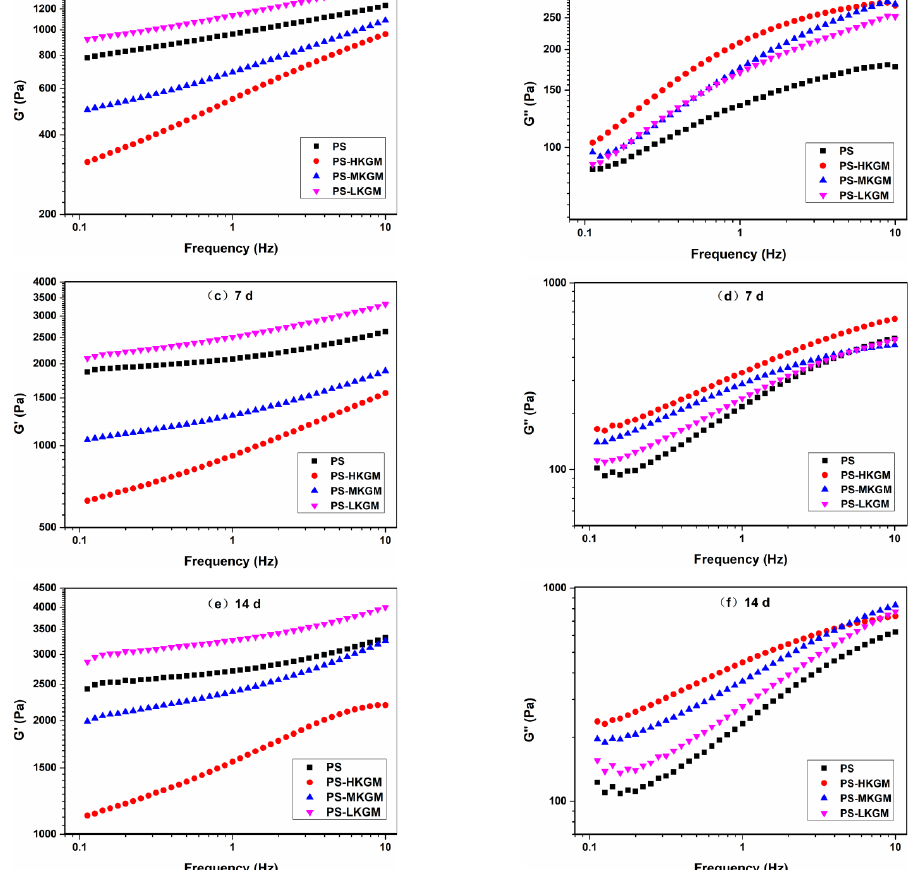
Figure 2. Frequency sweeping curves of PS - KGM mixtures at different storage times are as follows: ( a ) storage modulus at 1st day; ( b ) loss modulus at 1st day; ( c ) storage modulus at 7th day; ( d ) loss modulus at 7th day; ( e ) storage modulus at 14th day; ( f ) loss modulus at 14th day (HKGM, MKGM and LKGM represent KGM with high, medium and low molecular weight, respectively. PS represents pea starch).